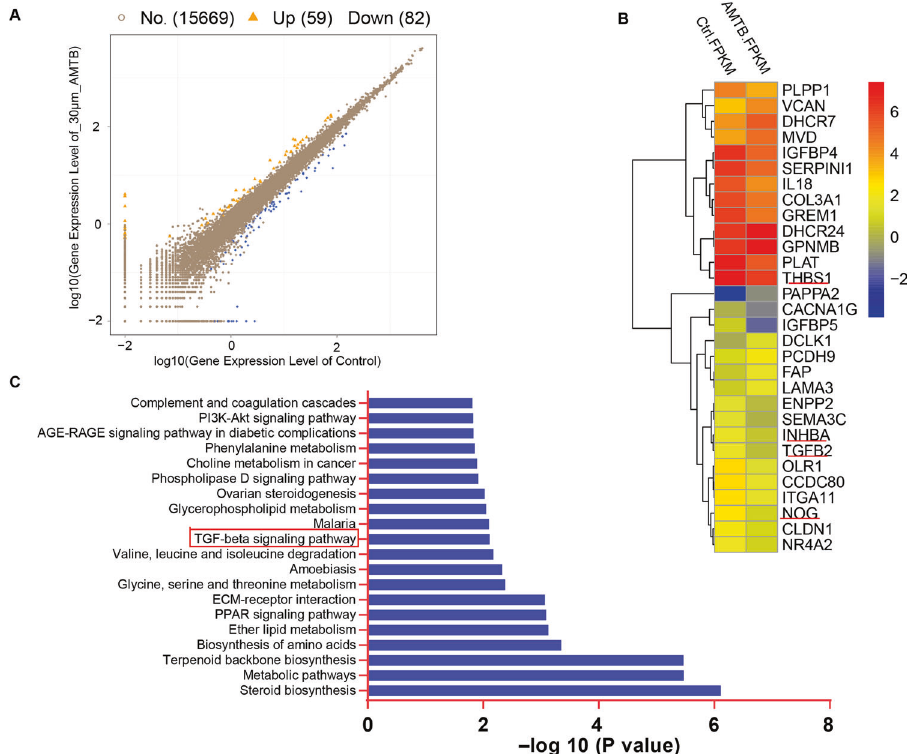
Fig. 4 The differentially expressed genes and signal pathway are involved in the treatment of AMTB in osteosarcoma. A Differentially expressed genes between AMTB 30 μ M treatment and control group, with fold change ≥ 2 and p value ≤ 0.05. B Heatmap colored according to the expression PFKM value, showing all of the differentially expressed genes involved in proliferation and metastasis. The red represent genes that are upregulated, and the blue represent genes that are downregulated. THBS1, INHBA, TGFB2, and NOG, primary KEGG enrichment members of this pathway, are indicated. C KEGG pathway analysis revealed a downregulation of TGF β signaling after treatment with AMTB 30 μ M in osteosarcoma